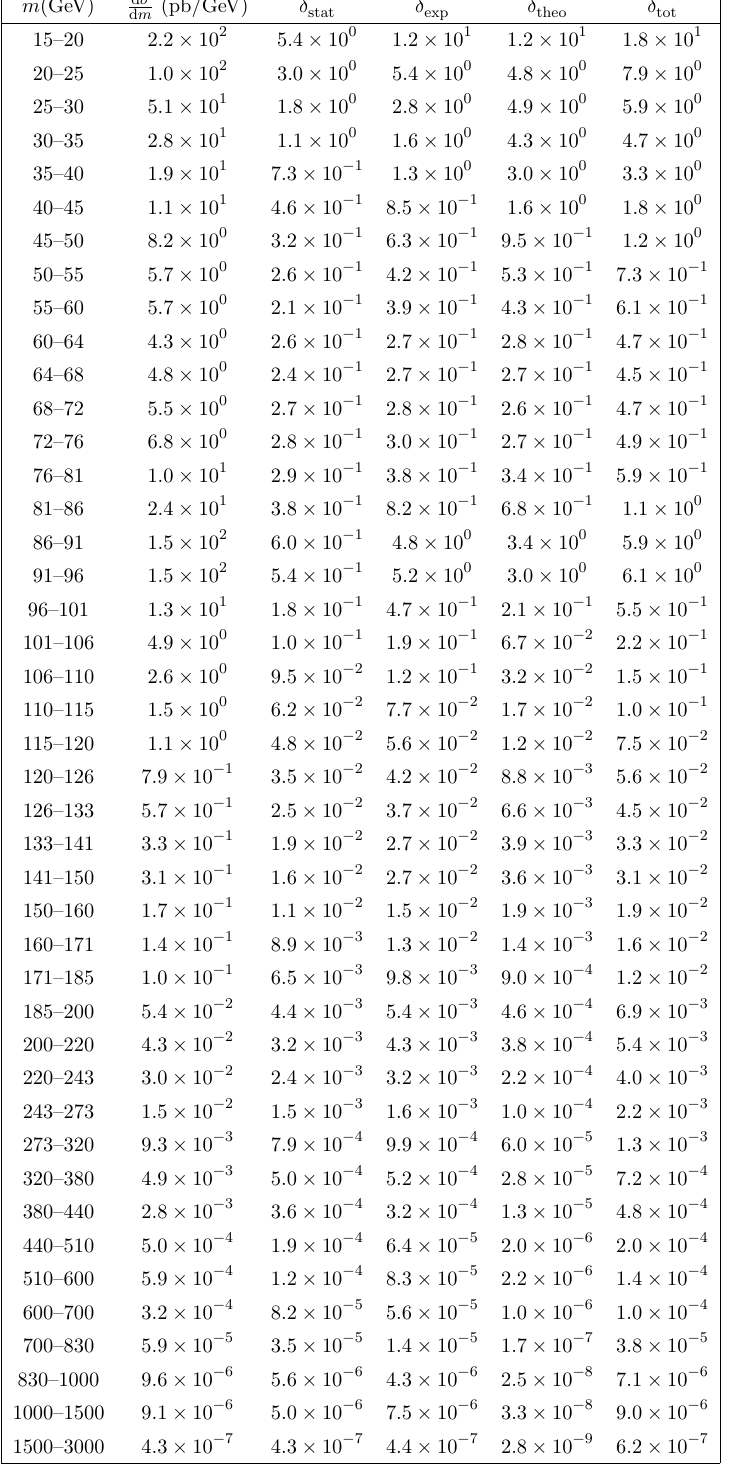
Table 4 . Summary of the measured values of d (cid:27)= d m (pb/GeV) in the dielectron channel with the statistical ( (cid:14) ), experimental ( (cid:14) ) and theoretical ( (cid:14) ) uncertainties, respectively. Here, (cid:14) stat exp theo is the quadratic sum of the three